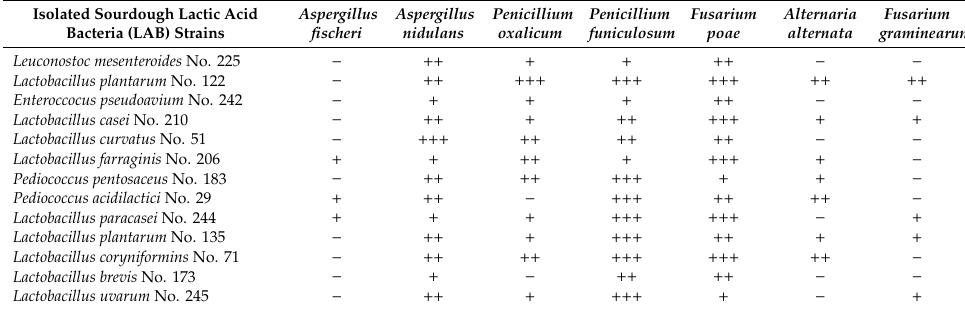
Legend: ( − ) No inhibition; ( + ) Delay of spore formation; ( ++ ) Delay of spore formation with a small clear zone of inhibition around the punched well; ( +++ ) A very good inhibition of mycelium growth and sporulation with large clear zones around the punched